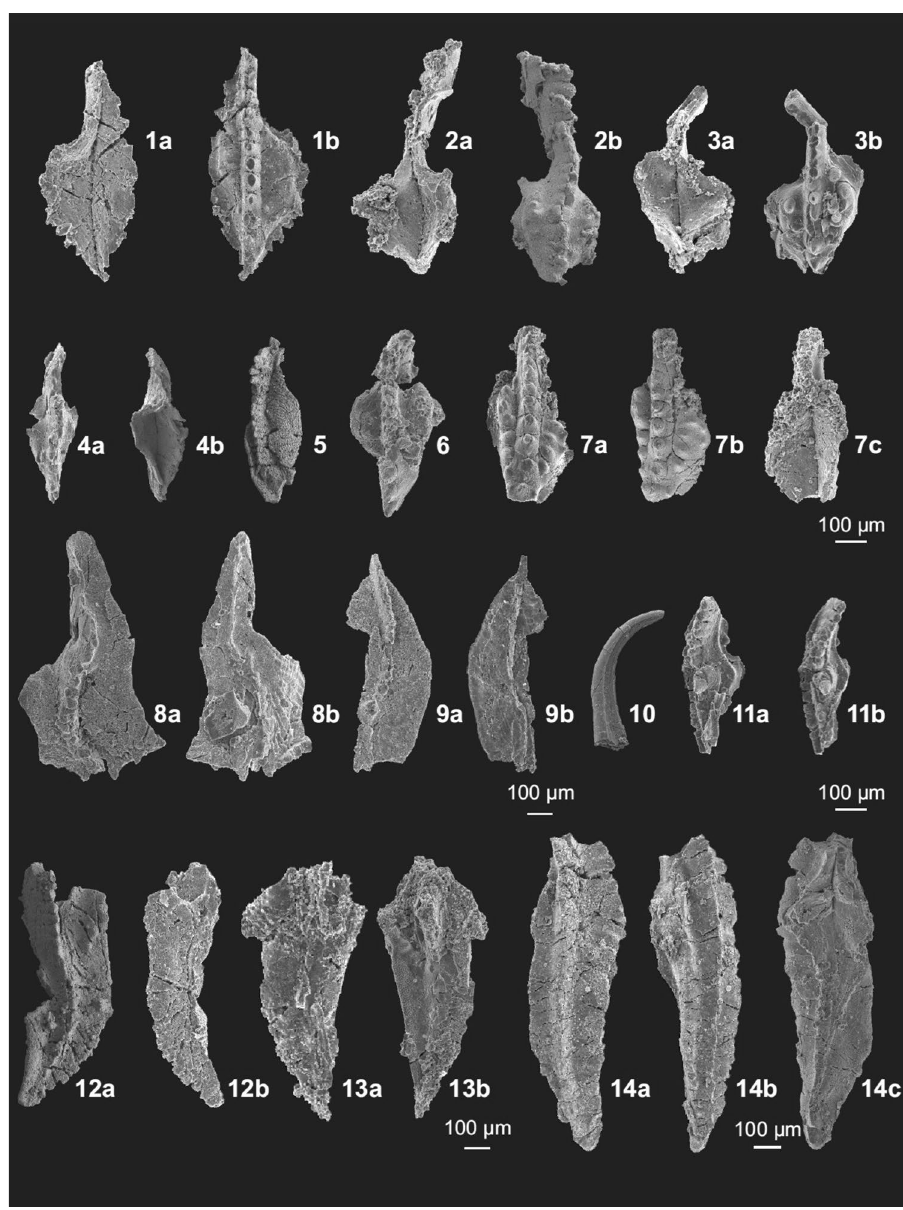
Figure 6. Conodonts from the Novchomok section. Most conodont elements illustrated in this figure are from sample Nov. 22-0, except the specimens in parts 9 and 14. 1, 2, 4. Protognathodus collinsoni Ziegler (1a. lower, 1b. upper views, MUZ PIG 1825.II.3; 2a. lower, 2b. upper views, MUZ PIG 1825.II.4; 4a. upper, 4b. lower views of juvenile form, MUZ PIG 1825.II.18), 3. Protognathodus collinsoni Ziegler → Protognathodus kockeli (Bischoff) (3a. lower, 3b. upper views, MUZ PIG 1825.II.5), 5, 9. Palmatolepis sp. (5. upper view of juvenile form, sample Nov. 22–0, MUZ PIG 1825.II.9; 9a. upper, 9b. lower views, sample Nov. 22–1, MUZ PIG 1825.II.10), 6. Pseudopolygnathus cf. Ps . brevipennatus Ziegler (6. upper view, MUZ PIG 1825.II.6), 7. Pseudopolygnathus aff. Ps . primus? Branson and Mehl (7a. upper, 7b. upper/oblique, 7c. lower views, MUZ PIG 1825.II.7), 8. Palmatolepis perlobata Ulrich and Bassler (8a. upper, 8b. lower views, MUZ PIG 1825.II.8), 10. Panderodus sp. (10. obverse view, MUZ PIG 1825.II.19), 11. Palmatolepis gracilis sigmoidalis Ziegler (11a. oblique, 11b. upper views, MUZ PIG 1825.II.20), 12, 13. Polygnathus sp. (12a. upper, 12b. lower/oblique views, MUZ PIG 1825.II.21; 13a. lower, 13b. upper views, MUZ PIG 1825.II.22), 14. Pseudopolygnathus sp. (14a. upper, 14b. lower, 14c. oblique views, sample Nov. 22–7, MUZ PIG